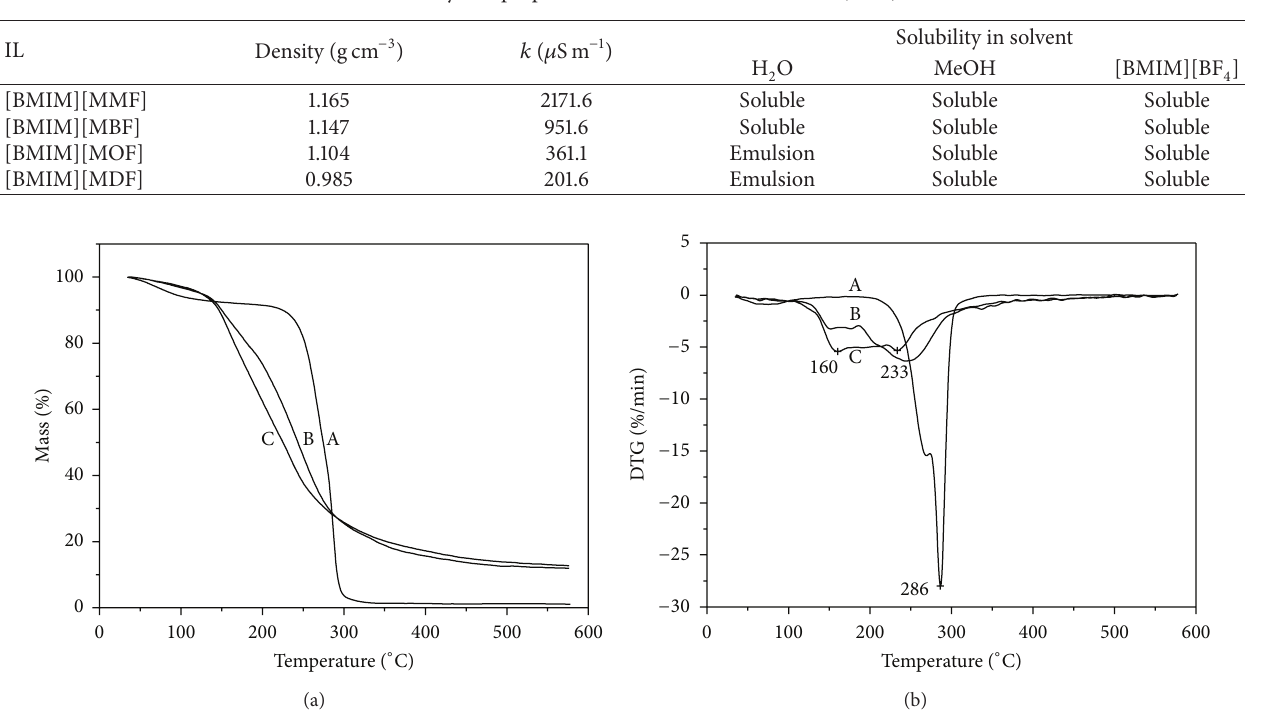
Figure 1: TG and DTG curves of ILs with fumarate anion. (A) [BMIM]Cl, (B) [BMIM][MMF], and (C)